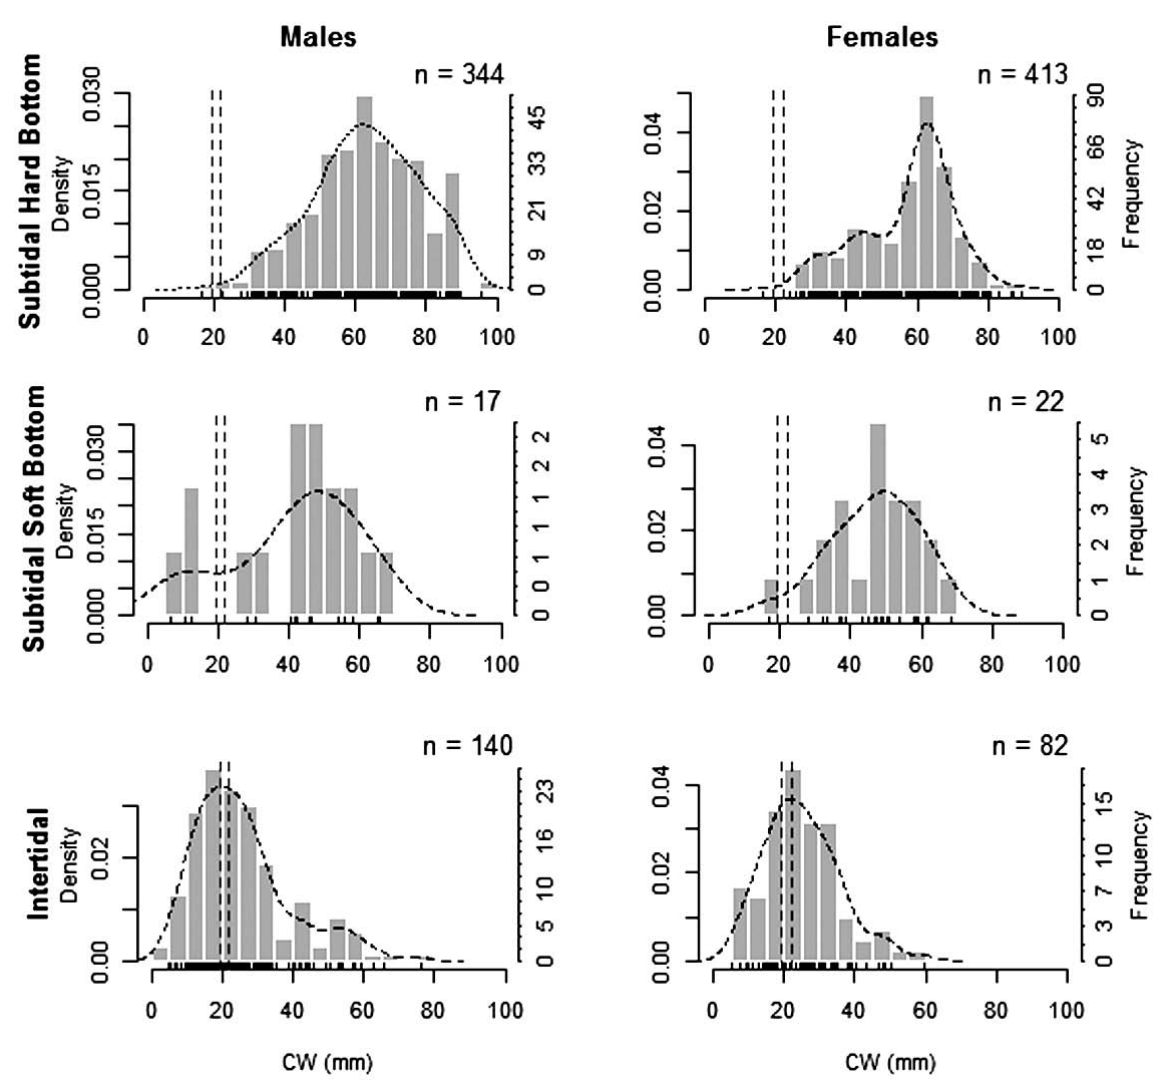
Fig. 4. – Size-frequency distribution of both sexes of Platyxanthus crenulatus sampled in different habitats. For the correspondent analysis the bandwidth of KDE was chosen by the Sheather and Jones (1991) bandwidth selection procedure. To facilitate visual comparisons, size classes on plots were all set to match the bandwidth for the males on subtidal hard bottom. Rug plot just above the x-axis indicates individual observa- tions. The two dashed vertical lines limit the confidence interval for 50% probability of change in colour pattern; ‘n’ indicates sample